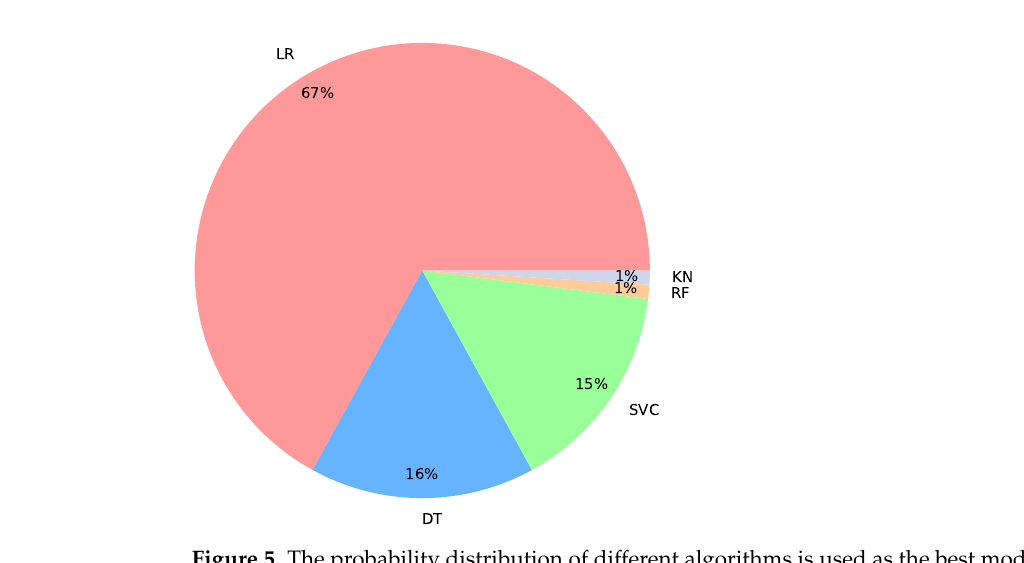
Figure 5. The probability distribution of different algorithms is used as the best